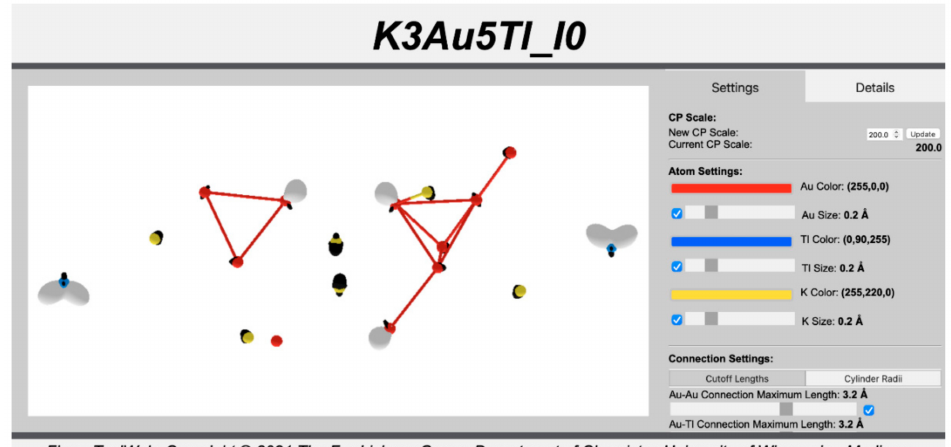
Figure 4. Default view of the K 3 Au 5 Tl structure obtained by loading the K3Au5Tl_I0.html file in a web